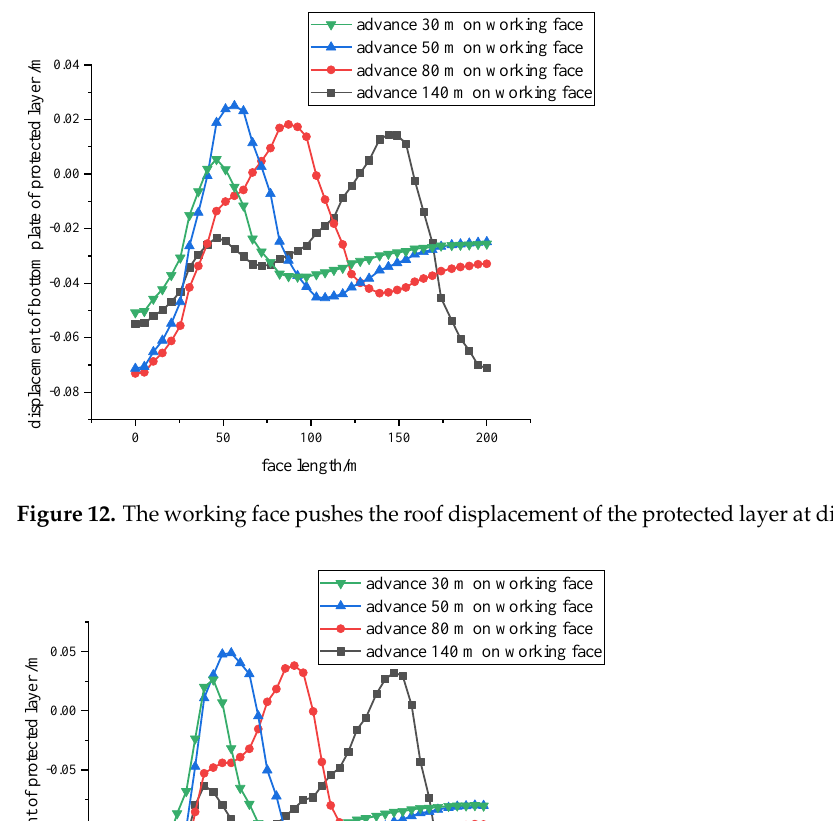
11 of 20 Figure 11. Pressure relief rate diagram of working face propulsion at different distances. 4.5.2. Analysis of Expansion Rate of Protected Layer in Mining Due to the pressure relief caused by the exploitation of the protective layer, the top and bottom floor of the protected layer will experience displacement. The expansion rate is used to determine the expansion size of the protected layer, and the formula is as fol- lows: / L M = (4) Where:  represents the expansion rate of the protected layer, L represents the dis- placement difference between the top and bottom of the protected layer in the mining process, and M represents the thickness of the protected layer before mining. Based on the coal and rock mass displacement diagram in Figure 6, the displacement variation diagrams of the top and bottom of the protected layer in Figures 12 and 13 can be obtained. The obtained data are then substituted into the above formula, and the ob- tained expansion rate is used to create the expansion rate curve of the protected layer after mining, as shown in Figure 14. It can be seen from the above figure that, in the process of mining the protective layer, the roof and floor of the coal seam under protection are subjected to pressure relief, re-